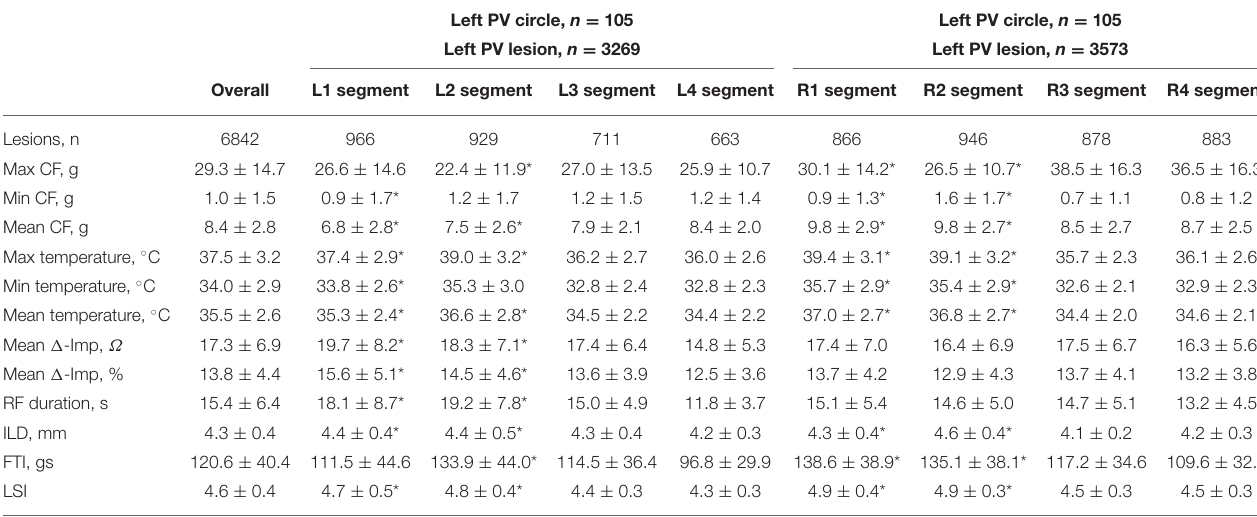
TABLE 2 | Ablation lesion results per segment.